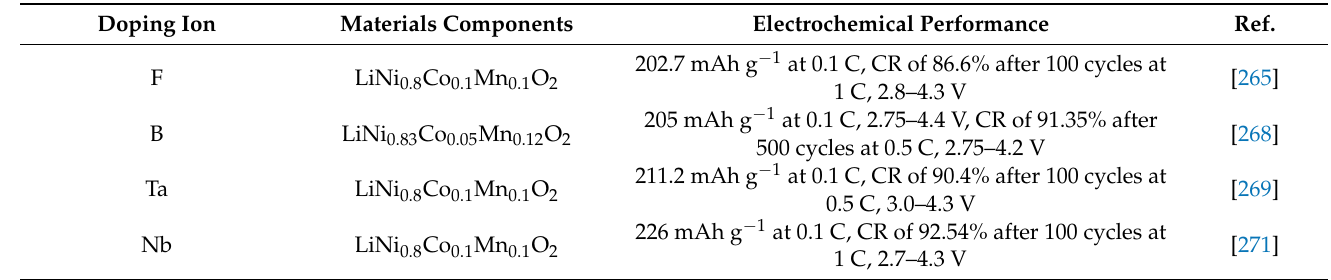
Table 2. Electrochemical properties of single-crystal nickel-rich NCM materials with different ion doping. (CR = Capacity